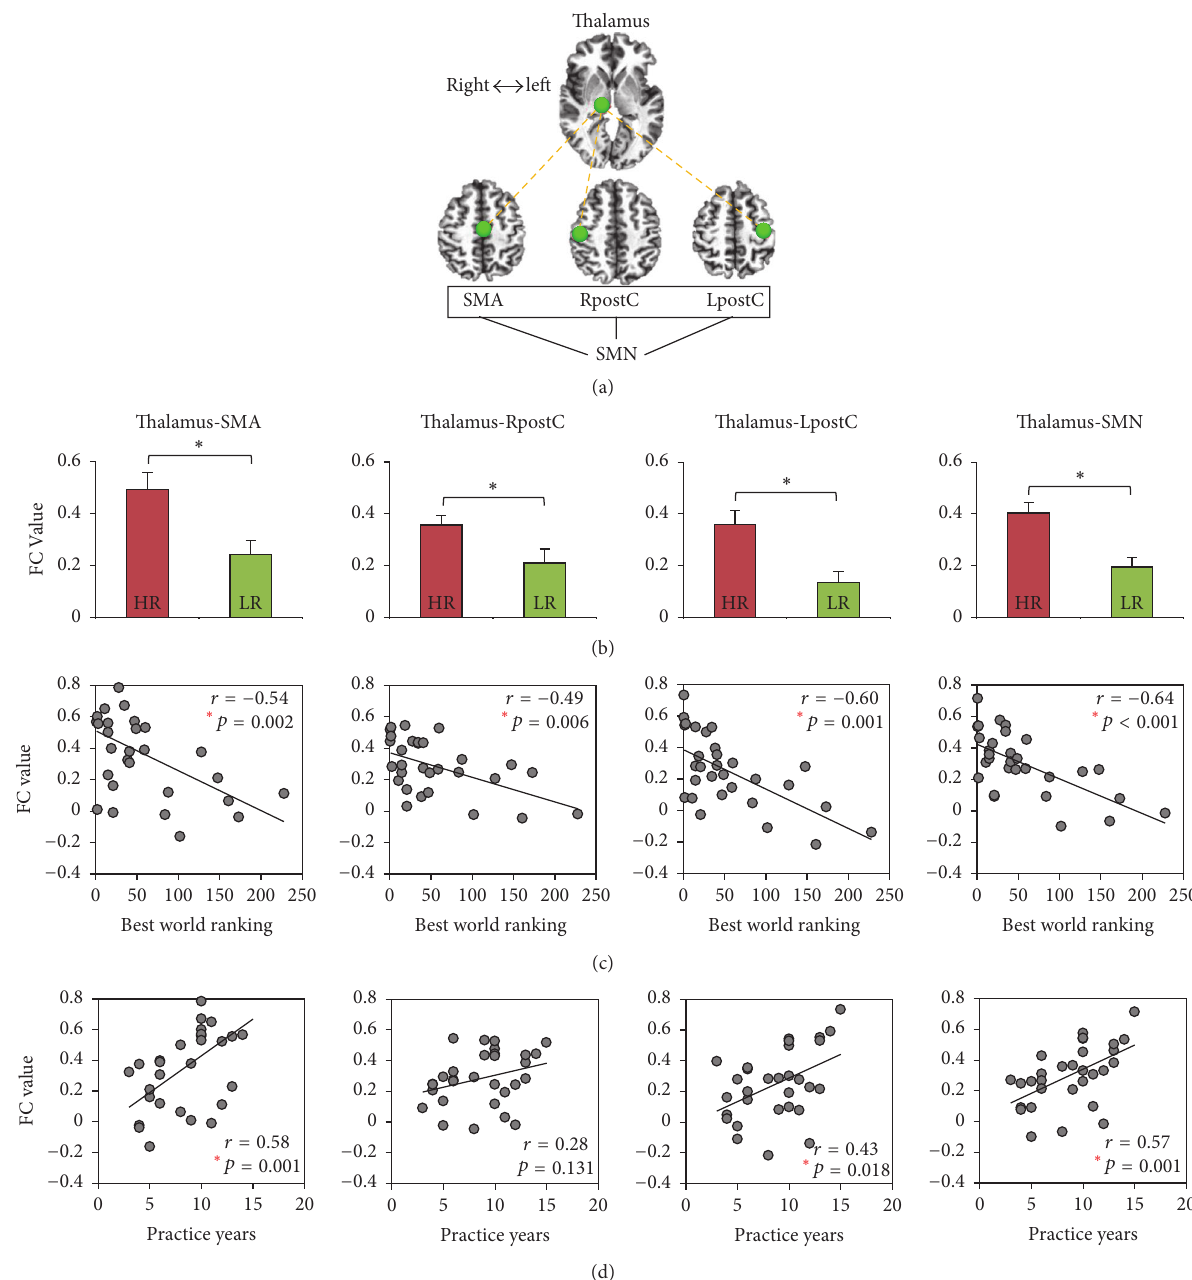
Figure 3: Functional connectivity (FC) of thalamo-sensorimotor circuits and its associations with performance excellence (best world ranking) and motor training (practice years). (a) An illustration of the regions of interest (ROIs) within the thalamo-sensorimotor circuits. The right thalamus is defined by the group difference in the degree of centrality analysis. The sensorimotor network (SMN), including supplementary motor area (SMA) and both the right postcentral gyrus (RpostC) and left postcentral gyrus (LpostC), is defined by left central sulcus-seedFC.(b)Groupcomparisonforhigh-ranked(HR)versuslow-ranked(LR)swimmersinthethalamo-sensorimotorFCs( ∗ 𝑝 < 0.05 ; errorbarsindicate ± SEM).(c)Correlationsbetweenthethalamo-sensorimotorFCsandbestworldranking( 𝑛 = 30 ).(d)Correlationsbetween the thalamo-sensorimotor FCs and practice years ( 𝑛 = 30 ). Spearman’s correlation analysis with a 95% confidence interval based on 1000 bootstrap samples was